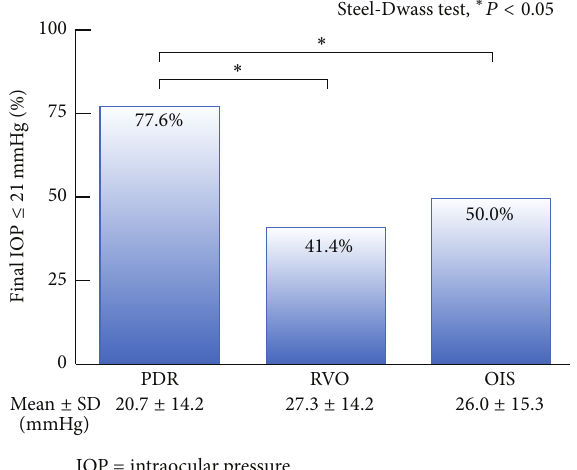
Figure 2: Final IOP values according to NVG causation. NVG patients with PDR had better IOP values than others.